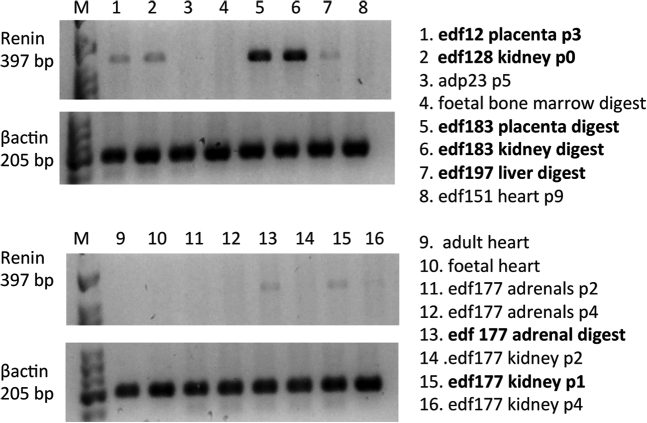
Renin gene expressions in renal and nonrenal tissue digests, and primary pericyte cultures. Among tested samples, the highest renin expression was present in the kidney and placenta digests, followed by kidney and placenta-derived cultured pericytes. Detectable renin expression was also found in the adrenal digest. β-actin was used as a housekeeping gene for real-time polymerase chain reaction. M, marker; p, passage.